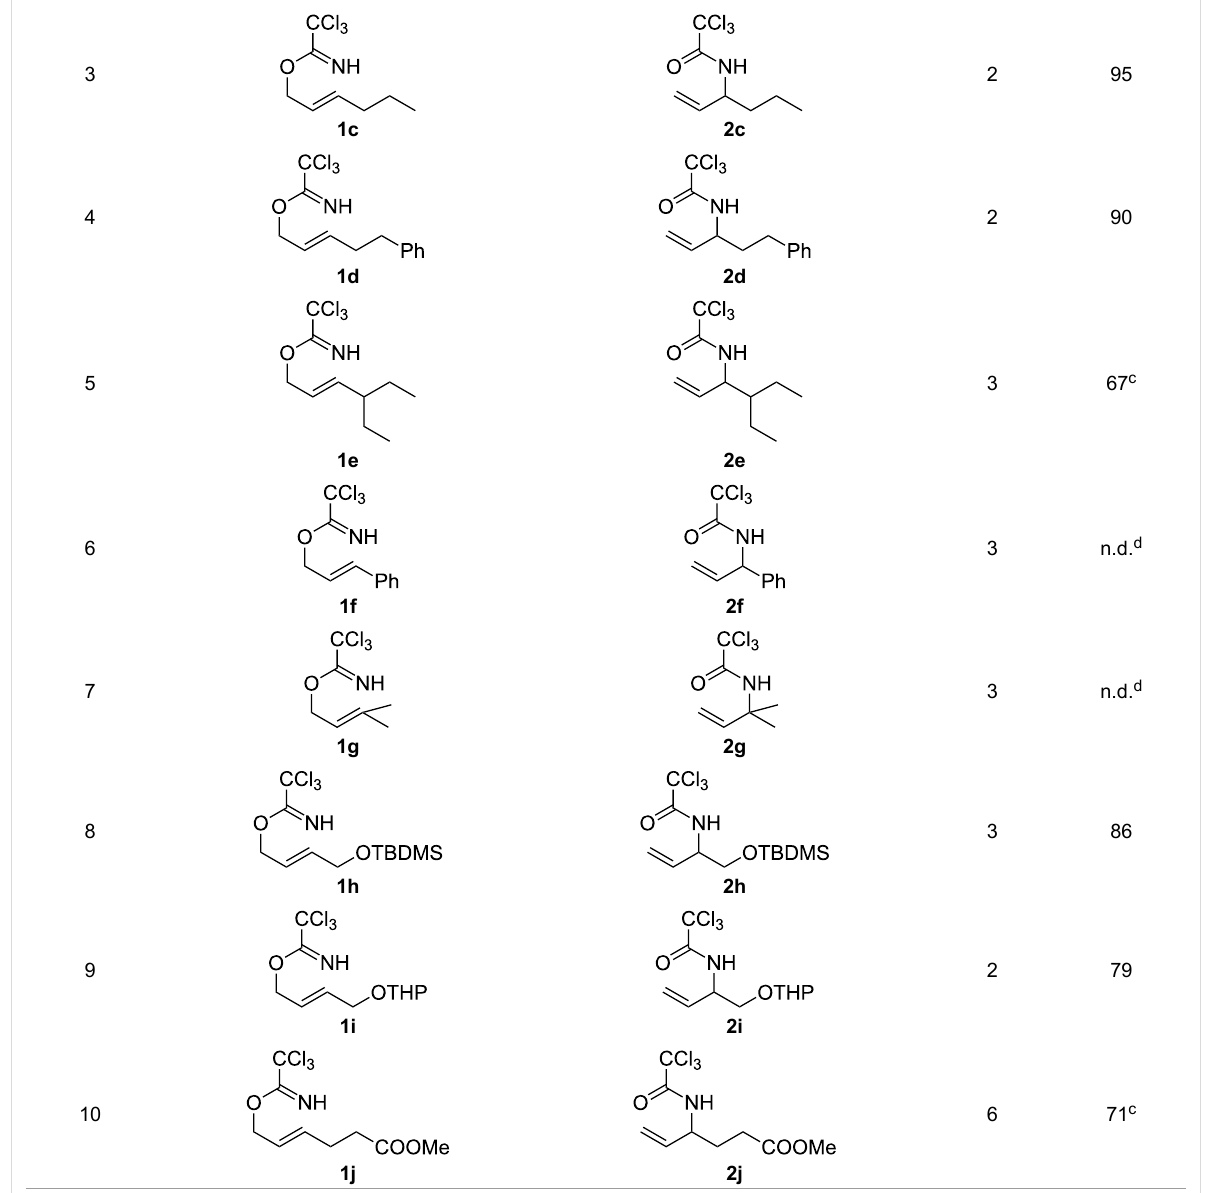
Table 2: Gold(I)-catalyzed Overman rearrangement in H 2 O. a